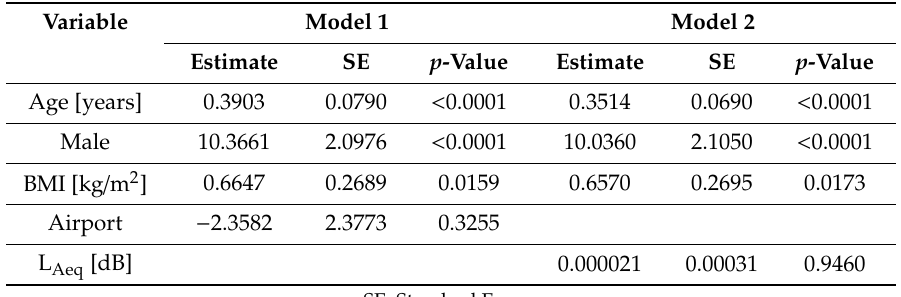
Table 6. Linear mixed e ff ect regression models for aircraft noise e ff ects on systolic blood pressure. Variable Model 1